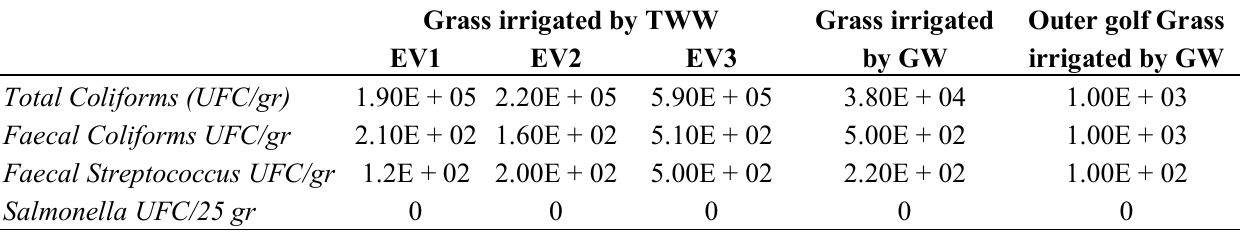
Table 6. Bacteriological tests of irrigated golf grass by treated wastewater and the groundwater at the end of 41 days and a turf irrigated by groundwater of an outer golf